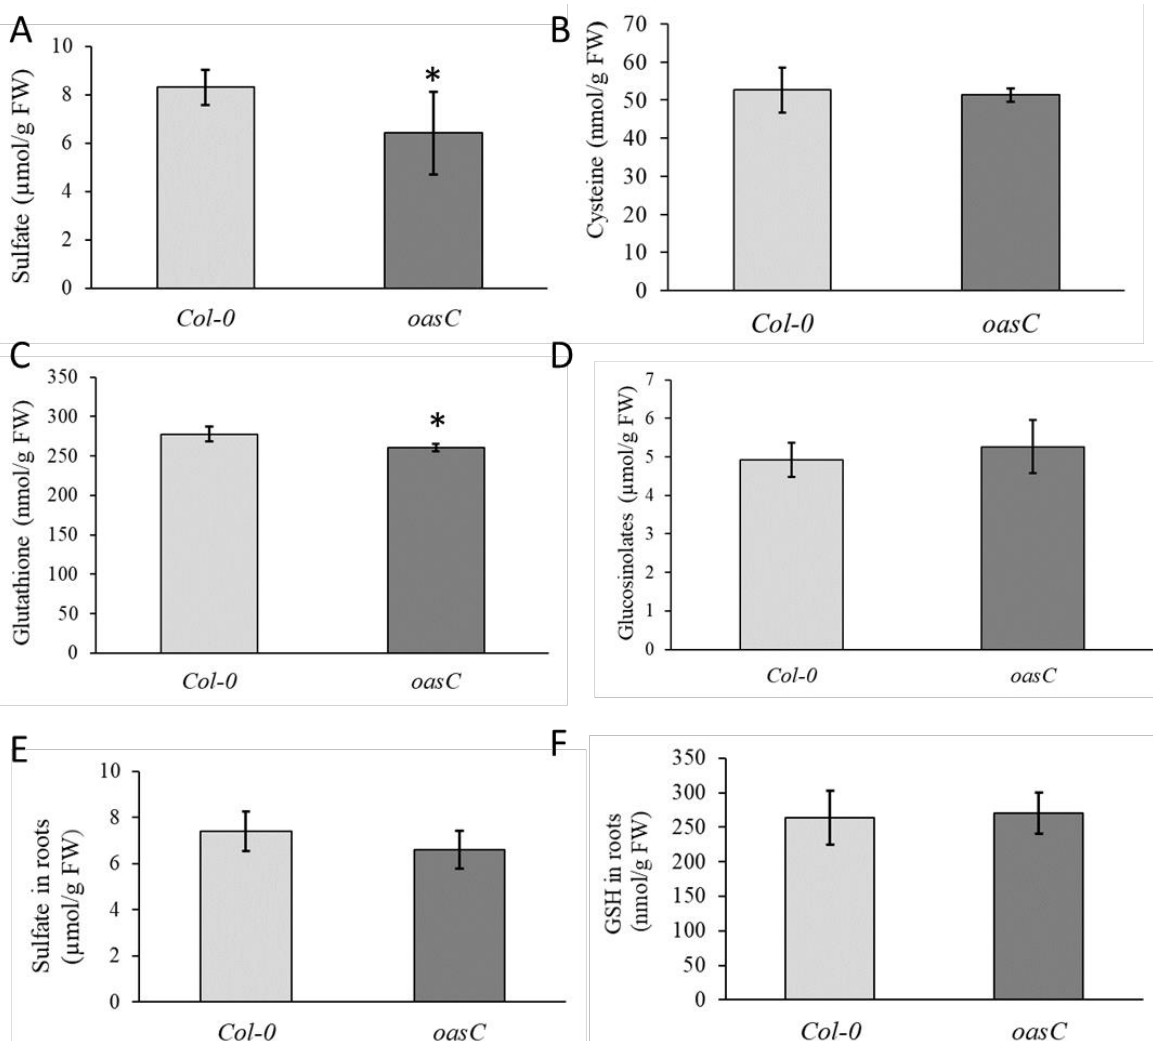
Figure 1. Disruption of OASC affects sulfur-containing metabolites. Col-0 (light grey) and oasC (dark grey) plants were grown for 2.5 weeks on MS-agarose plates. The content in the leaves of ( A ) sulfate, ( B ) cysteine, ( C ) glutathione, and ( D ) glucosinolates, as well as of ( E ) sulfate and ( F ) glutathione in roots was measured. Data are presented as means ± S.D. from four biological replicates. Asterisks mark values significantly different from the wild-type Col-0 at p < 0.05 (Student’s t -test).